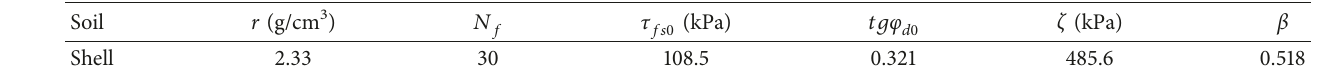
Table 2: Parameters of cyclic shear strength.